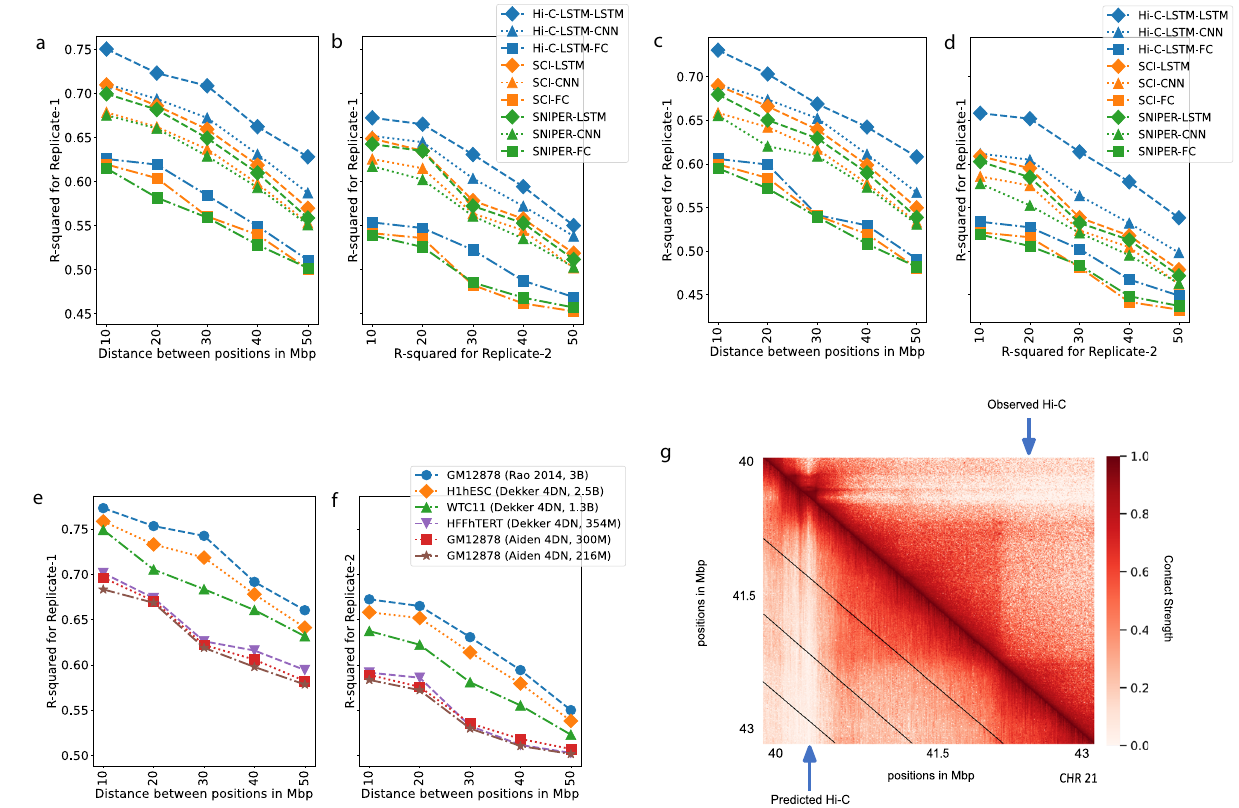
Fig. 3 Accuracy with which representations reproduce the observed Hi-C matrix. a , b The Hi-C R -squared computed using the combinations of representations from different methods and selected decoders for replicate 1 and 2 (GM12878). The horizontal axis represents the distance between positions in Mbp. The vertical axis shows the reconstruction accuracy for the predicted Hi-C data, measured by average R -squared. The R -squared was computed on a test set of chromosomes using selected decoders with the representations trained all chromosomes as input. The legend shows the different combinations of methods and decoders, read as [representation]-[decoder] . c , d Same as ( a , b ), but for H1-hESC. e , f Hi-C R -squared computed for different cell types. g A selected portion of the observed Hi-C map (upper-triangle) and the predicted Hi-C map (lower-triangle) in GM12878. The portion is selected from chromosome 21, between 40 and 43 Mbp. Diagonal black lines denote Hi-C-LSTM's frame boundaries (see the “ Methods ”